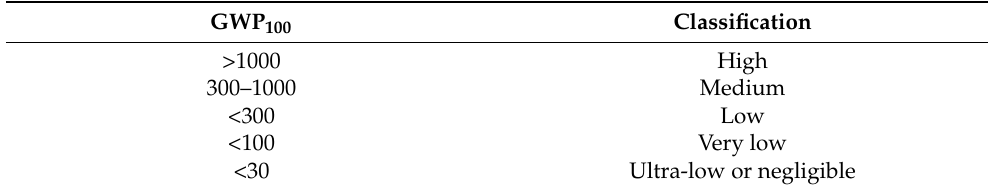
Table 3. Classification of GWP 100 levels